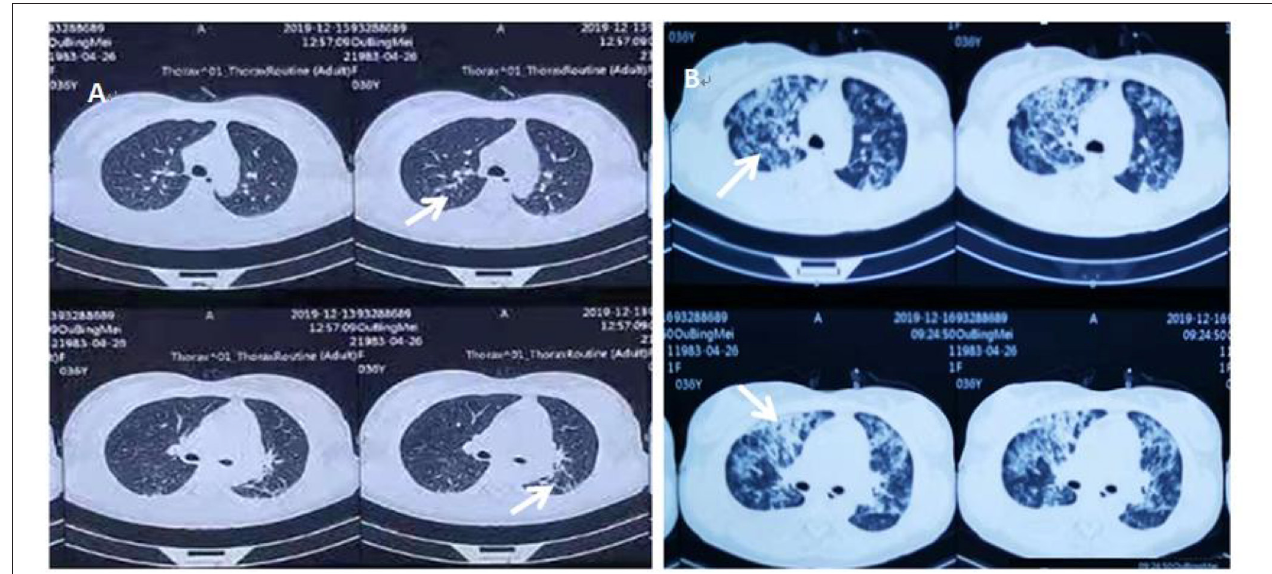
FIGURE 1 | (A) The patient’s initial chest CT examination results when she visited Zhongshan Hospital affiliated to Xiamen University on December 13, 2019, after 1 week of fever. (B) The repeat chest CT at Zhongshan Hospital affiliated to Xiamen University on December 16, 2019, after the patient’s dyspnea worsened. White arrows indicate multiple patchy blurred shadows in bilateral lungs, which had progressed compared to initial